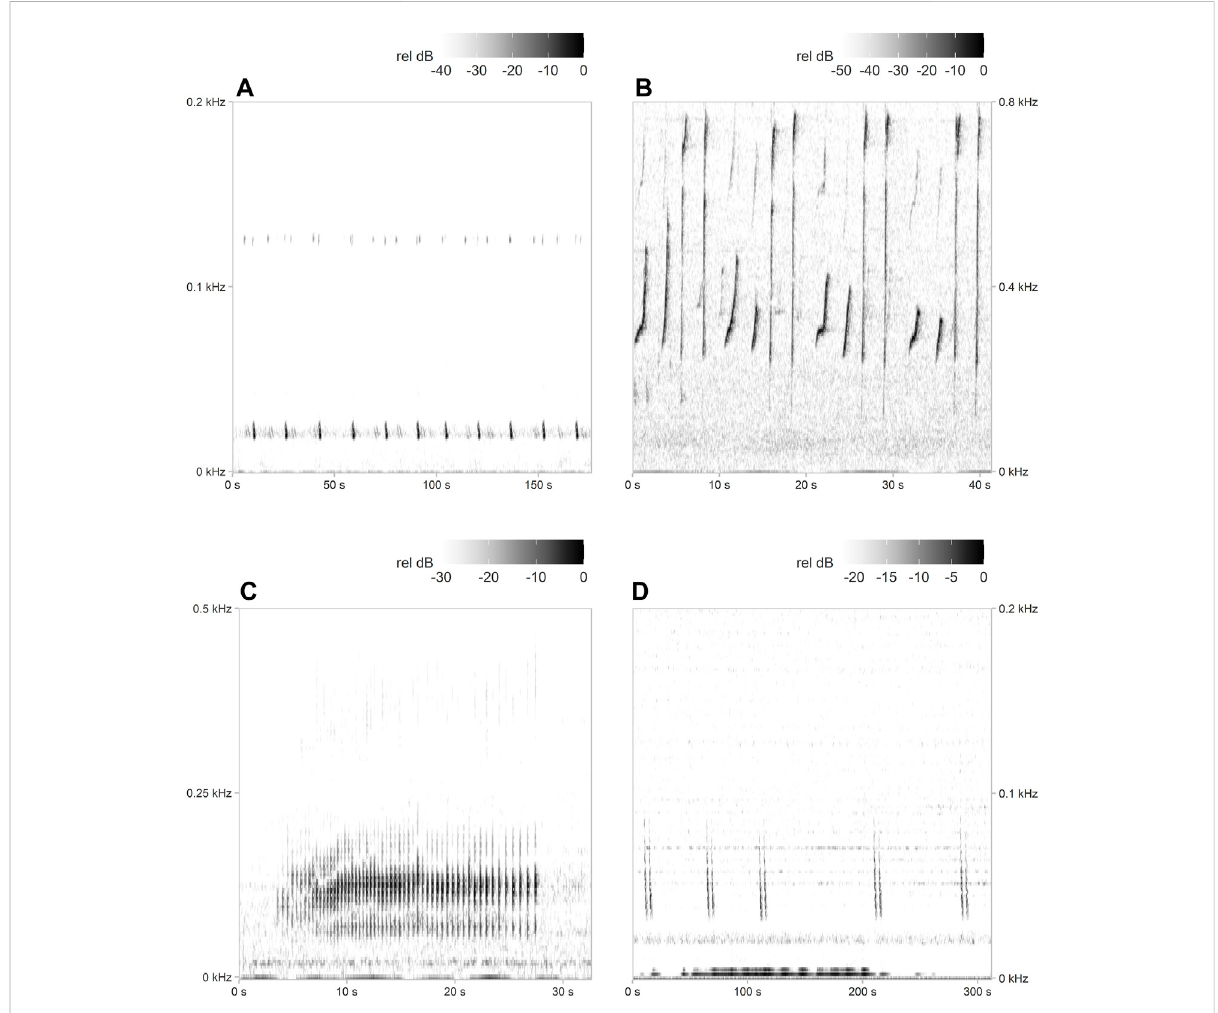
FIGURE 2 Example spectrograms of (A) fi n whale song, (B) humpback whale song, (C) minke whale song, and (D) sei whale downsweeps, which were all detected in the current study. Note the different time ( x -axis) and frequency scales ( y -axis). Spectrogram parameters: fast Fourier transform (FFT) size = 1,024 (B,C) and 2048 (A,D) points, overlap = 95%, sample rate = 2000 Hz, frequency resolution = 1.95 Hz (B,C) and 0.98 Hz (A,D) , and time resolution = 25.6 ms (B,C) and 51.2 ms (A,D)